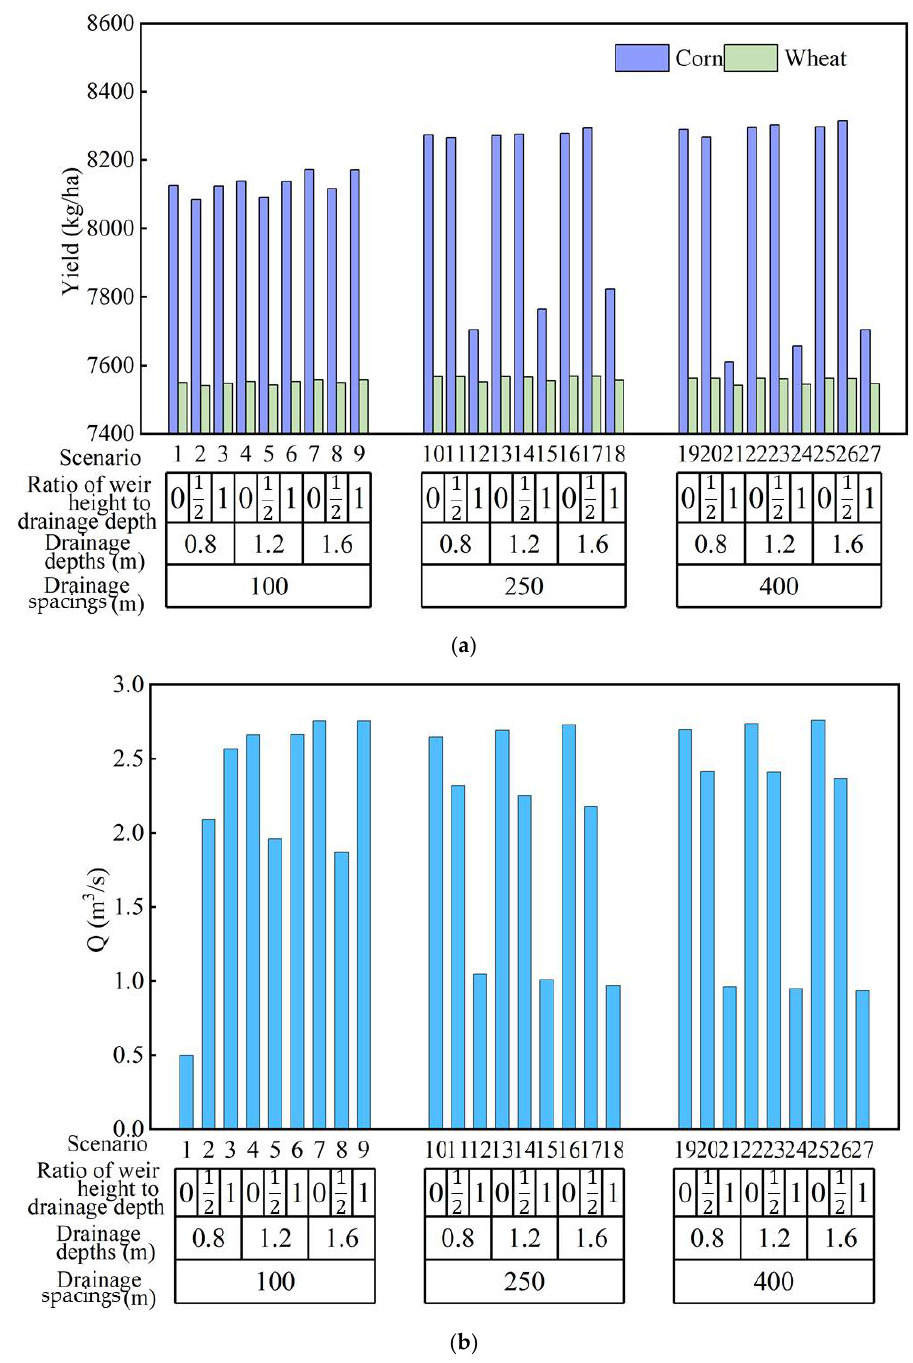
Figure 6. Changes in evaluation indexes under different field ditch water depth control scheme. ( a ) Crop yield; ( b ) regional drainage discharge (Q).